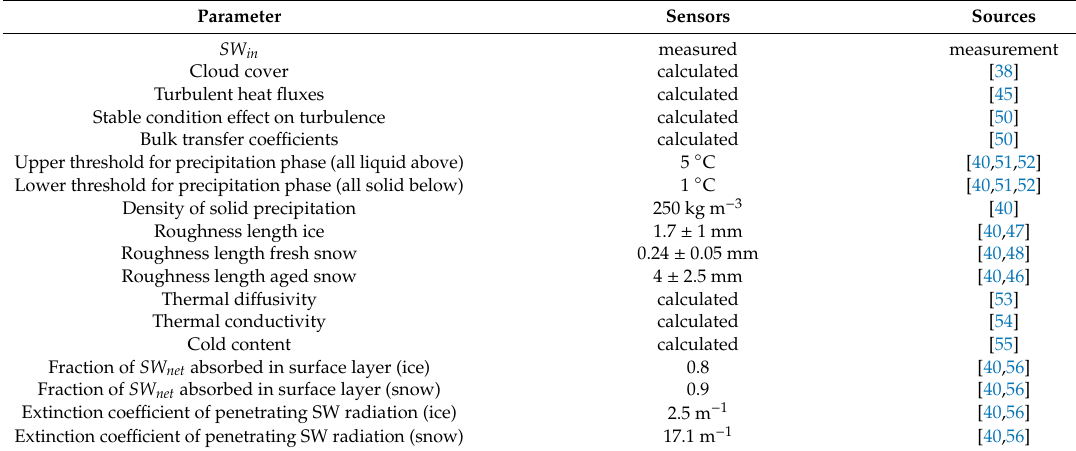
Table 2. Parameters for the glacier energy and mass balance model on Urumqi Glacier No. 1